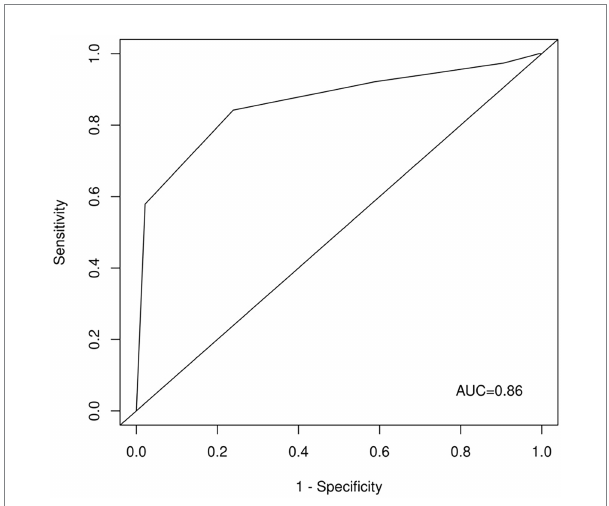
FIGURE 1 ROC curve for questions one, two, three, four, five, and six. AUC-area under the curve.